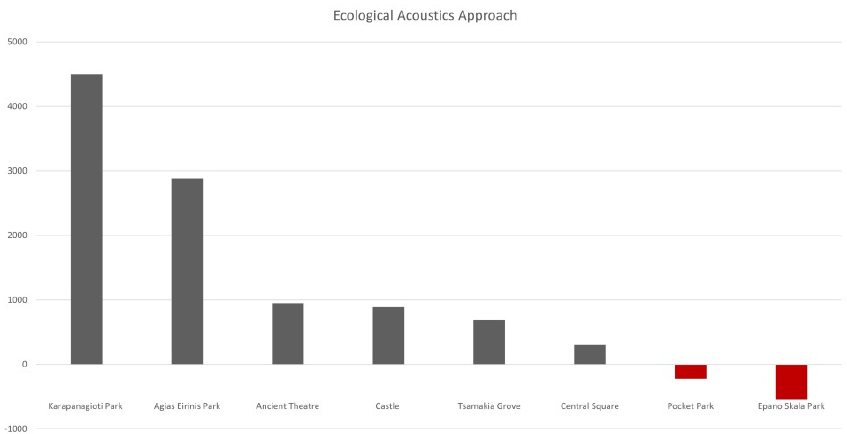
Figure 8. Potential quiet areas ranked using the Ecological acoustics approach. The negative values of CUQI (red bars) derived due to the use of NDSI that indicates anthropophony with a negative sign.